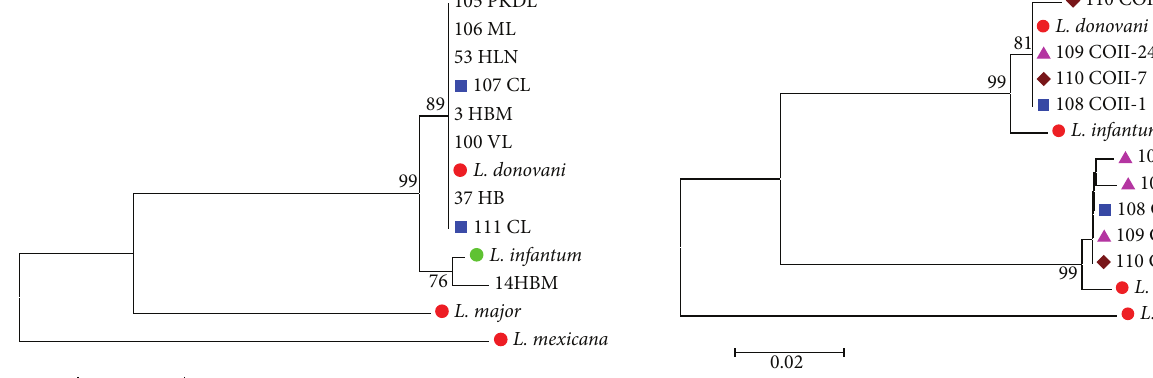
Figure 1: Phylogenetic tree of COII sequences. Phylogenetic tree based on a fragment of 570 bp of COII gene of Leishmania parasite. Sequence dataset was analysed using MEGA 5, the neighbor- joining (NJ) method, and bootstrap analysis (1,000 replicates) based on the ClustalW algorithm. Significant bootstrapping values ( > 70%) are shown on the nodes. Only representative sequences were shown. Number indicates the sample number, HBM indicates human blood marrow origin sequence, HLN indicates lymph node origin sequence, and HB indicates human blood origin sequence used in this study. Blue square: sequence numbers 107 and 111 originated from skin culture amplificates and associated with CL patients; red circle: Leishmania GenBank reference sequence ( L. donovani GenBankaccessionnumberAY660023, L.major GenBank accession number AF63316, and L. mexicana GenBank accession number HQ586845.1 ); green circle: our positive control L. infantum MHOM/TN/80/IPT1 used in this study.